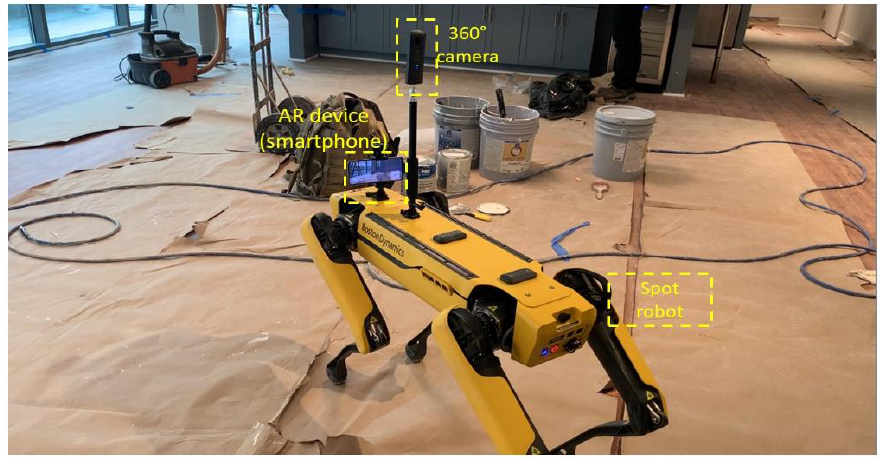
Figure 4. Robotic